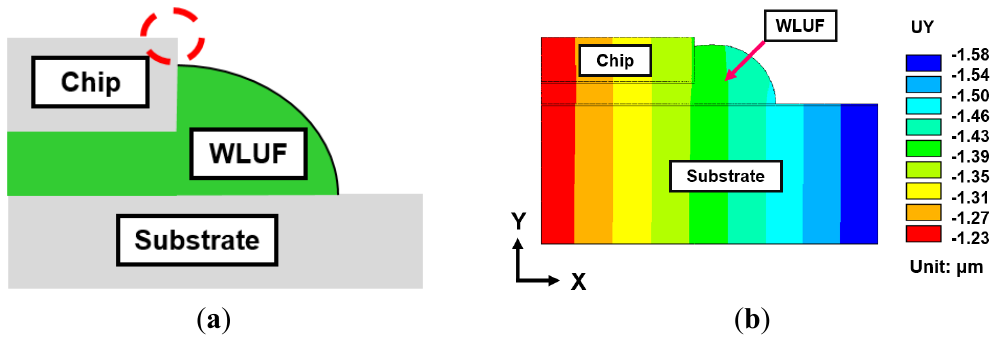
Figure 8. Concerned location of the proposed package with chip stackings: ( a ) outermost top edge of stacked chips; ( b ) enlarged view of the warpage contour of the outermost region of the package with